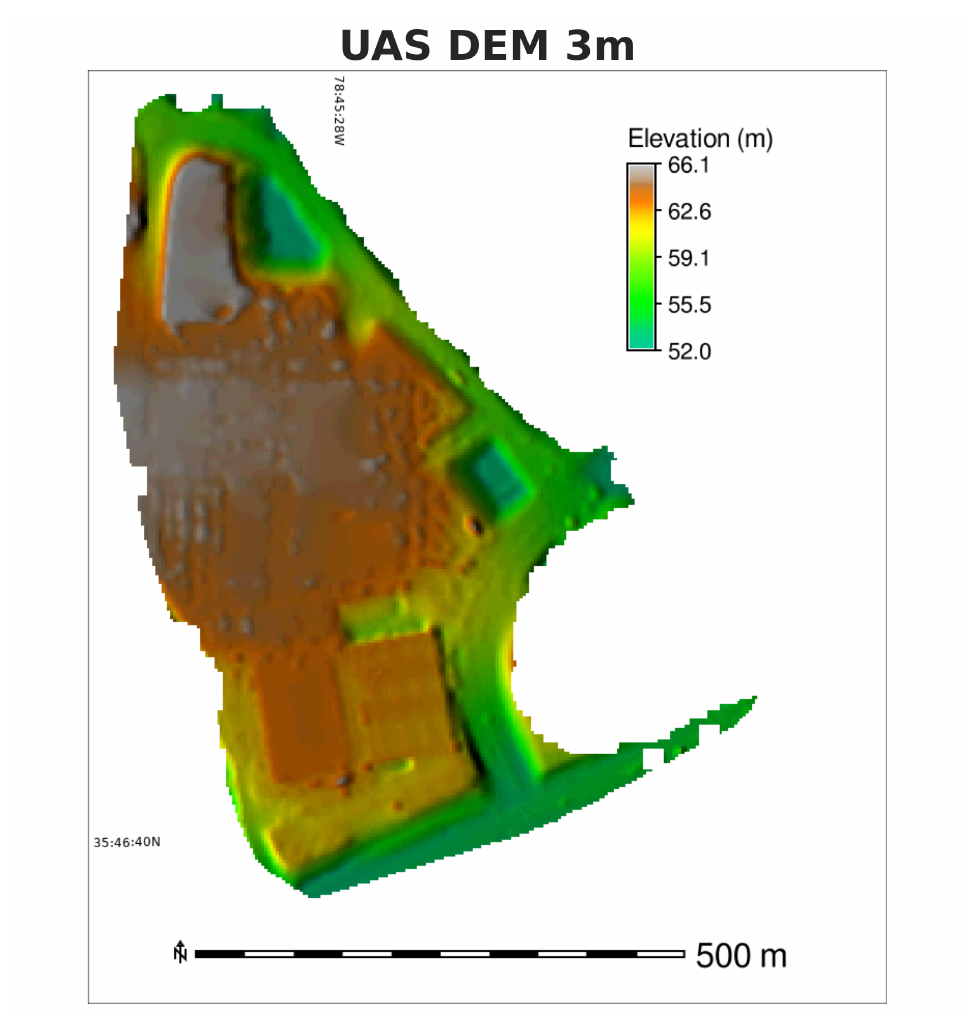
Figure 11. UAS DEM resampled to 3 m resolution with vegetation and structures removed before fusion with the USGS NED